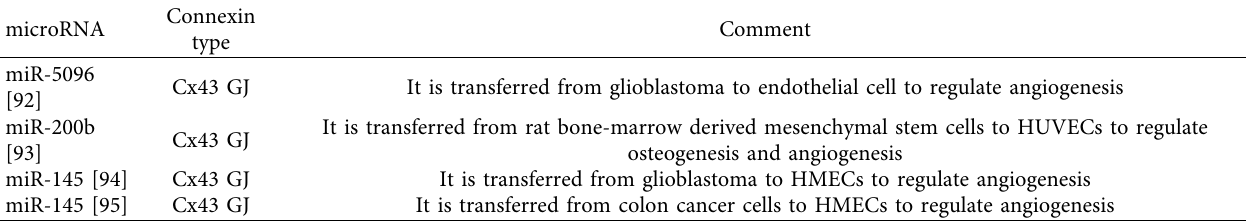
Table 3: Effect of Cx43 on